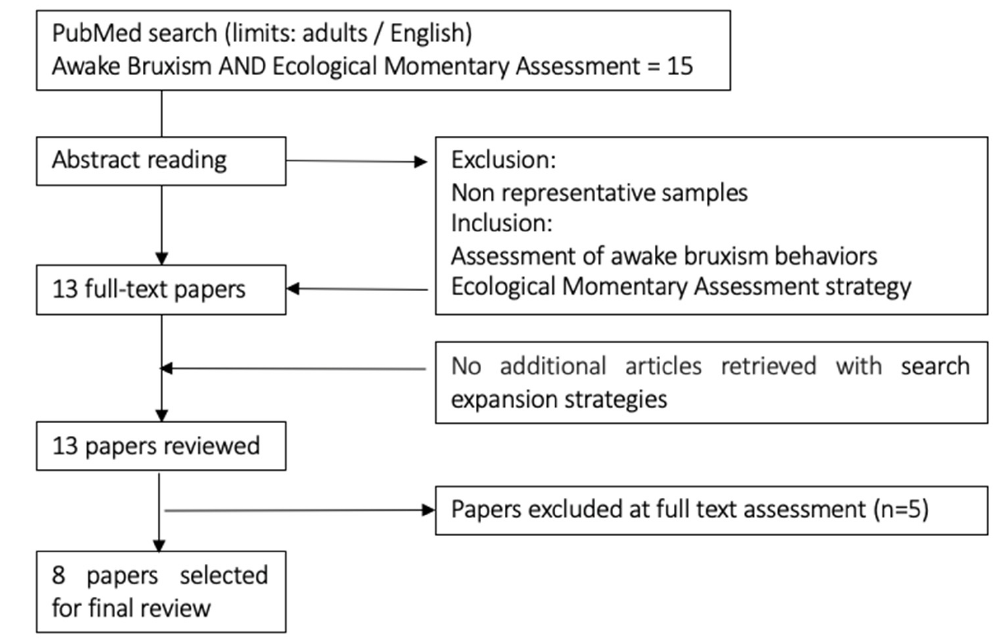
Figure 1. Literature search strategy. Different steps and criteria for the selection of papers.